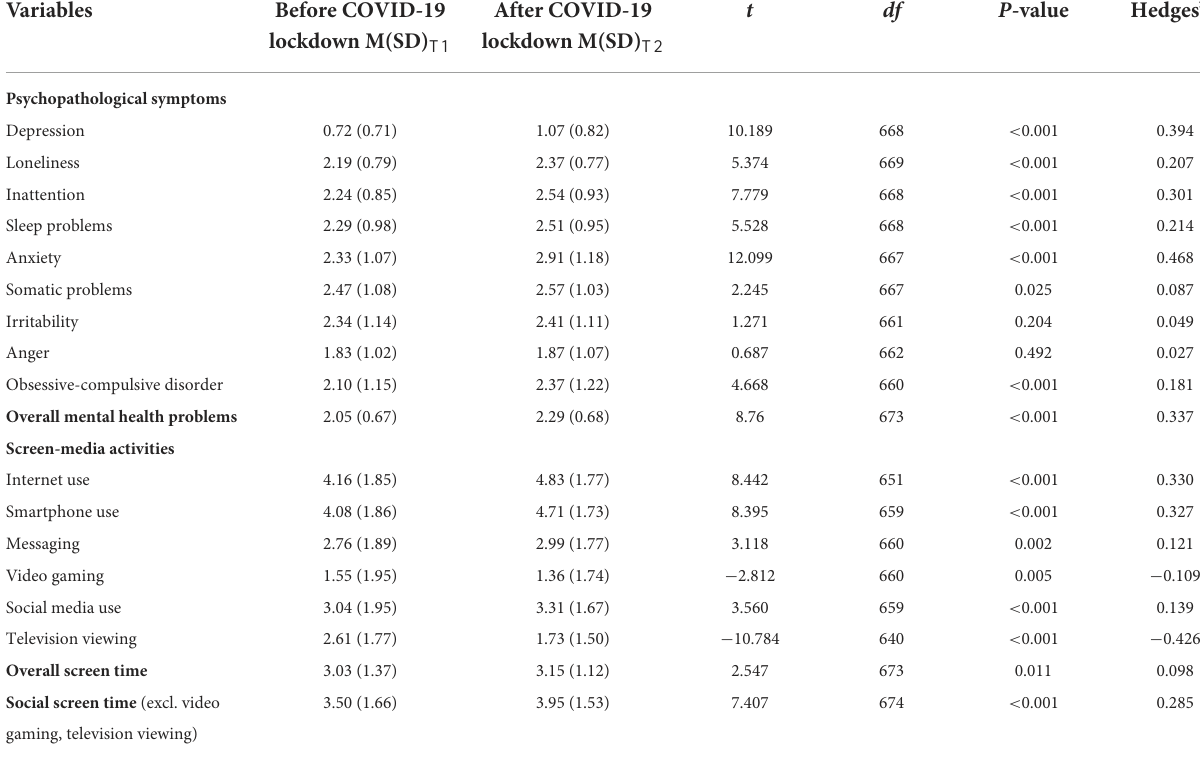
TABLE 1 Means, standard deviations, and paired-samples t-tests results.